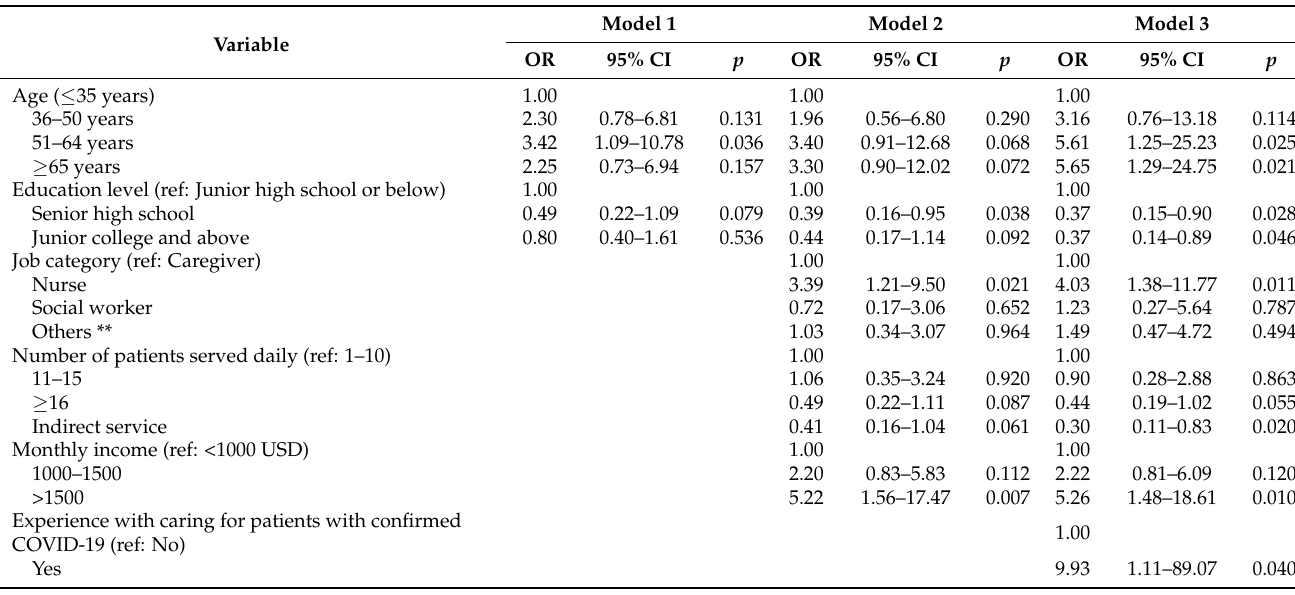
Table 5. Logistic regression analysis of willingness to provide care to patients with COVID-19 ( n = 275)